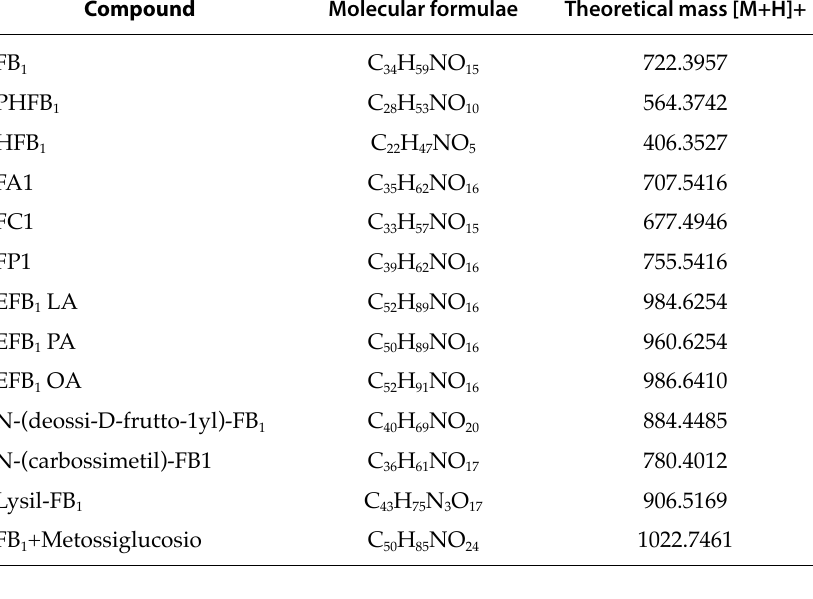
Table 3. Summary of compounds searched to identify potential degradation products by LC-HRMS with molecular formu- lae and accurate mass values (theoretical mass) of characteristic ions.